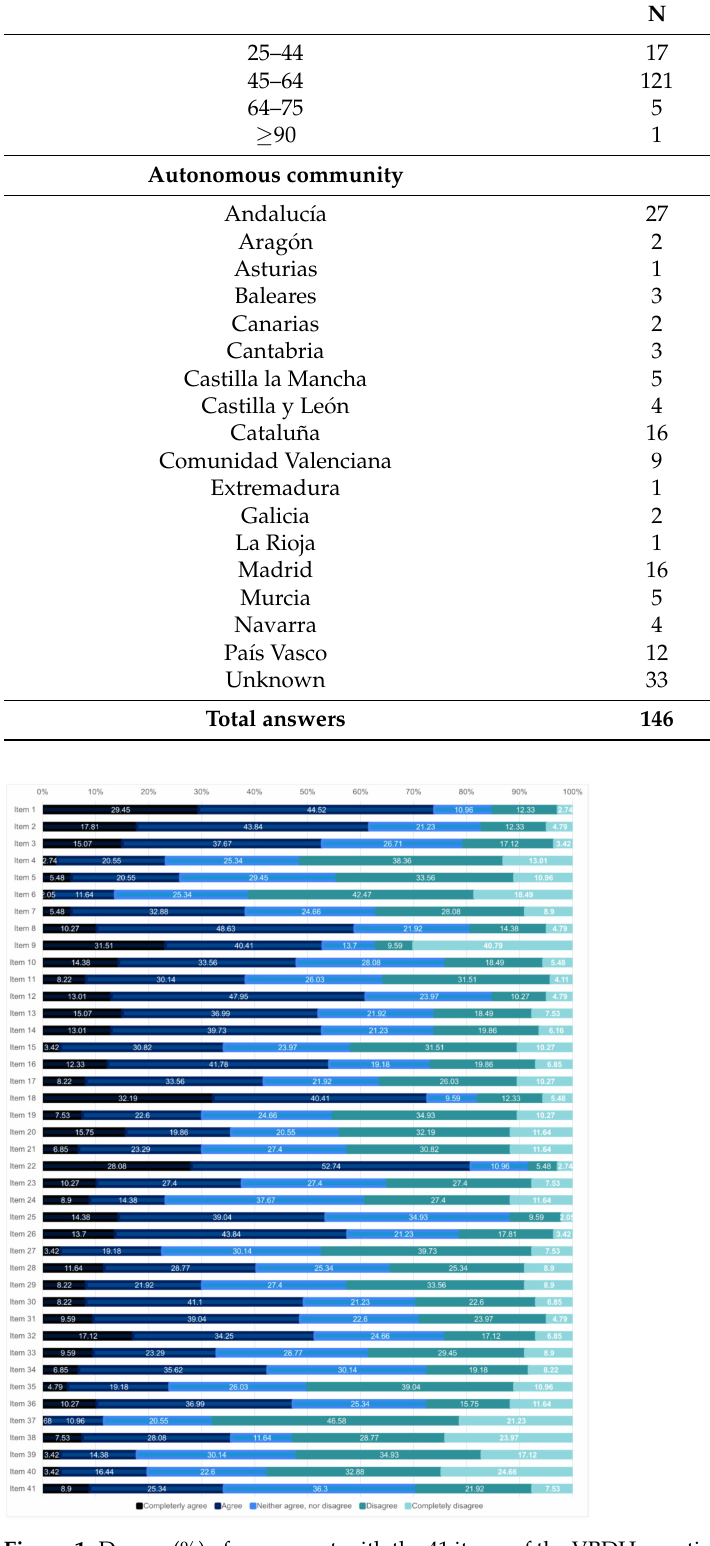
Figure 1. Degree (%) of agreement with the 41 items of the VBDH questionnaire. The item description (translated to English) is provided in Table 2 below, and the original questionnaire (in Spanish, the original language) is also provided as Supplementary